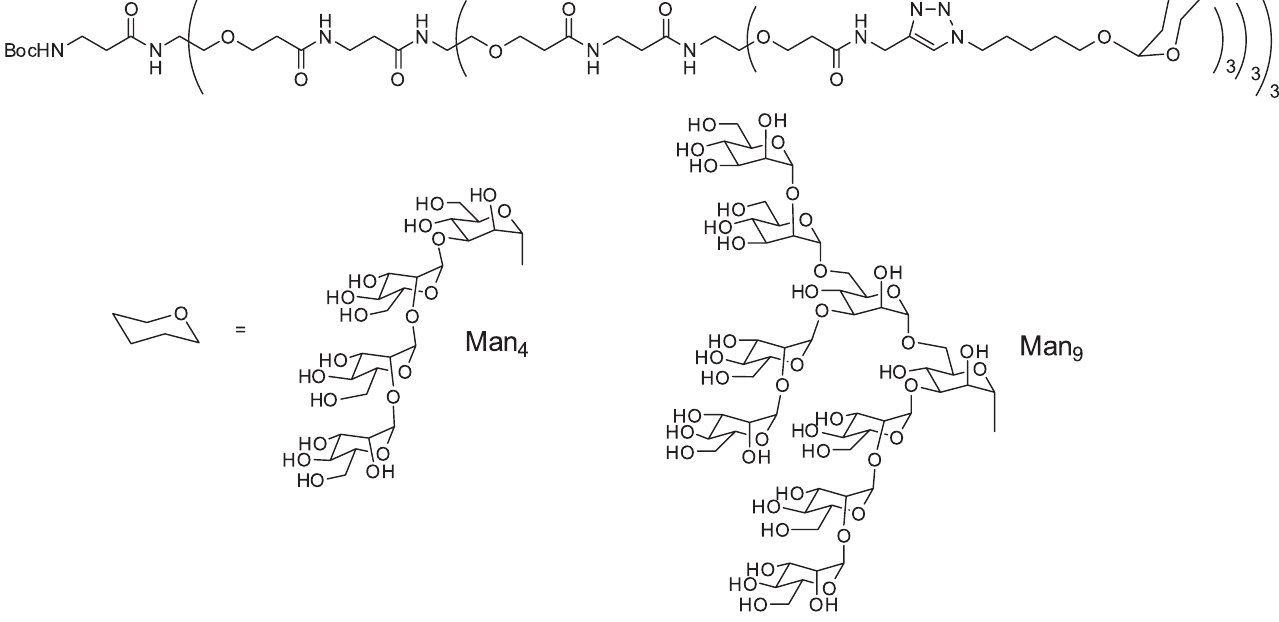
FIGURE 4 - Glycodendrons with 27 copies of Man